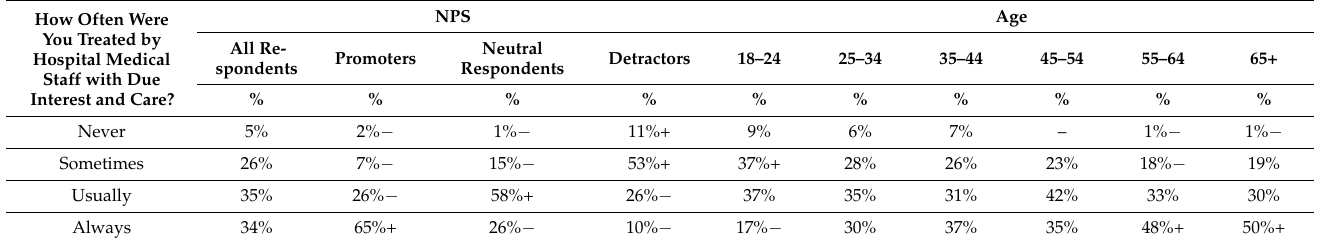
Table 2. Analysis of patients’ opinions on being treated with due interest and care by the medical